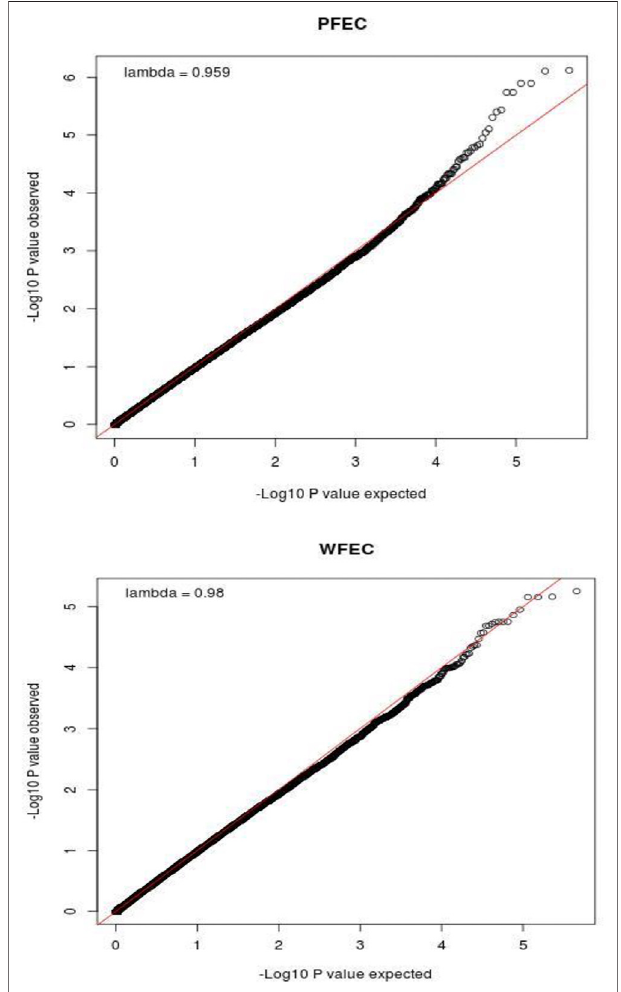
FIGURE 2 | QQ plots showing the relationship between observed and expected values for -Log 10 (P) for postweaning (PFEC) and weaning (WFEC) fecal egg count EBV from the single-SNP genome-wide association study using a pedigree-based relationship matrix. P is the nominal signi fi cance level for each